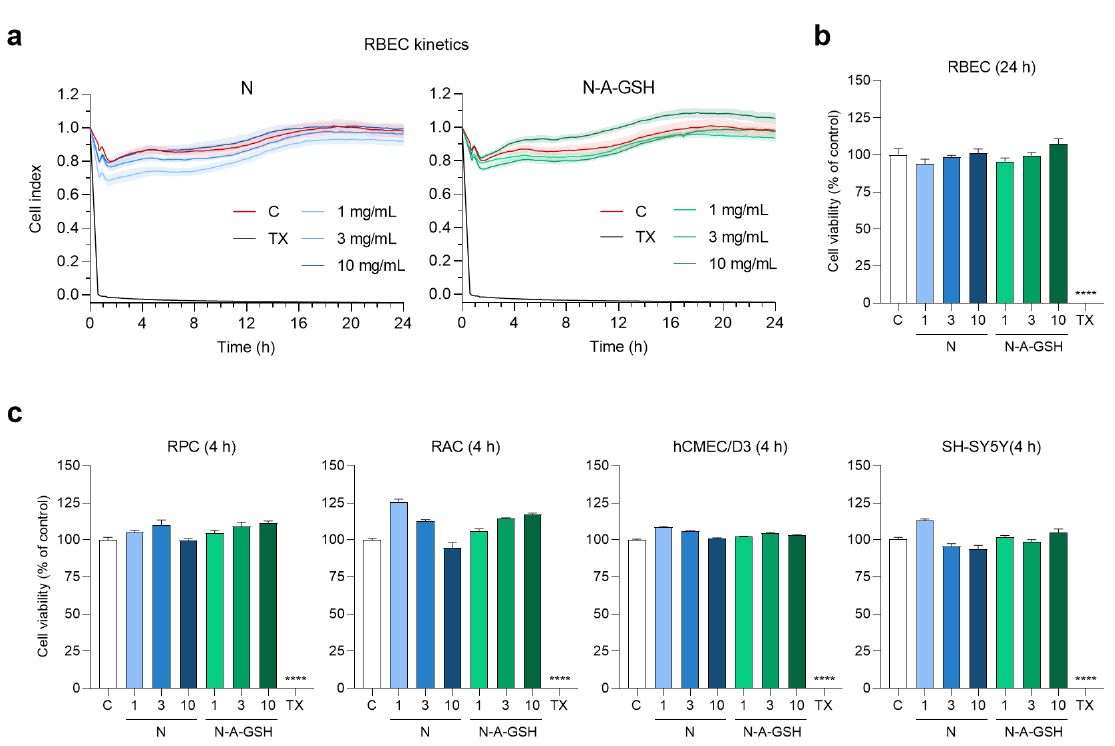
Figure 3. Effect of non-targeted (N) and alanine-glutathione dual-targeted (N-A-GSH) niosomes at concentrations of 1, 3 or 10 mg/mL on the viability of NVU cells monitored by real-time impedance measurement. ( a ) Kinetics of rat brain endothelial cell responses to niosome treatments for 24 h. Values presented are means ± SEM and are given as cell index. ( b ) Rat brain endothelial cell viability after 24 h. ( c ) Cell viability of pericytes (RPC), astrocytes (RAC), hCMEC/D3 endothelial cells and SH-SY5Y neurons after 4 h. Values presented are means ± SEM and are given as a percentage of control. Statistical analysis: one-way ANOVA followed by Dunnett’s posttest; **** p < 0.0001 compared to the control group; n = 6–8. C: culture medium-treated control group; TX: Triton X-100 reagent, indicating maximum cellular toxicity.